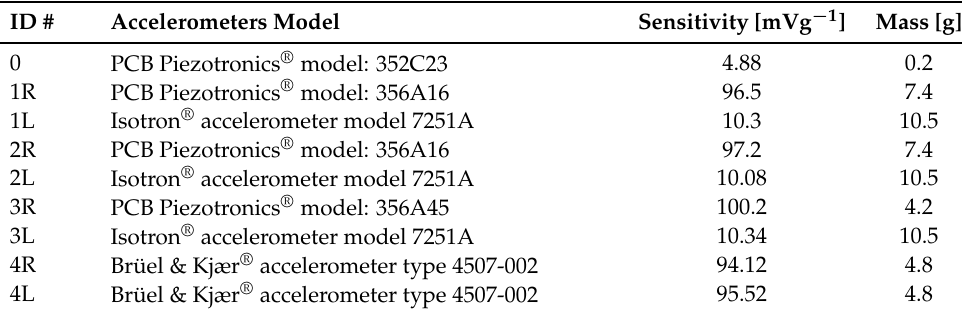
Table 7. Accelerometers